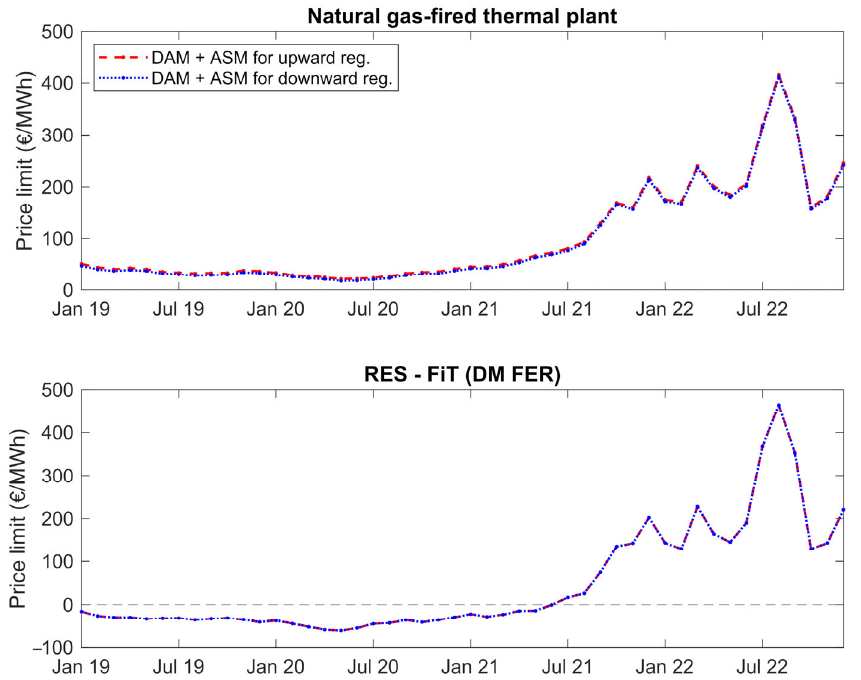
Figure 9. ASM price limit for downward (upward) regulation below (over) which the ASM participation is profitable.